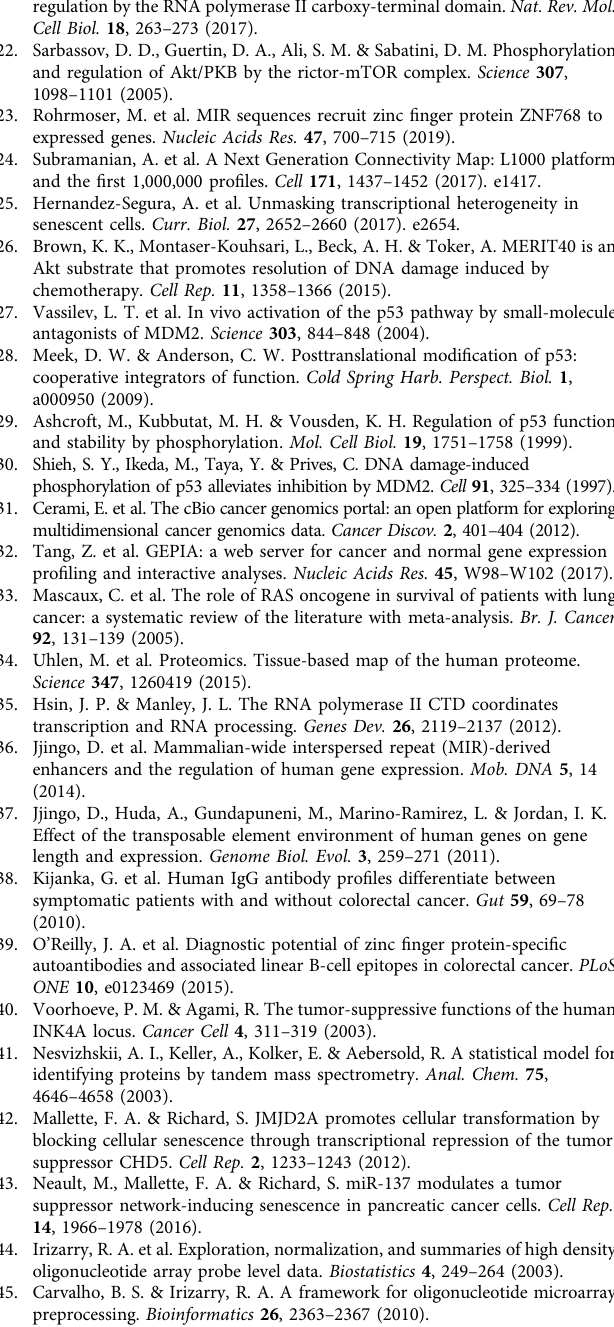
Figure 6 : The results presented in Fig. 6D, E come from the analysis of 38 human tumors and corresponding normal lungs ( n = 28 LUAD and n = 10 LUSC). The results presented in Fig. 6F are part of a tissue microarray that was performed twice, with similar outcome for many lung tumors. Reporting summary . Further information on research design is available in the Nature Research Reporting Summary linked to this